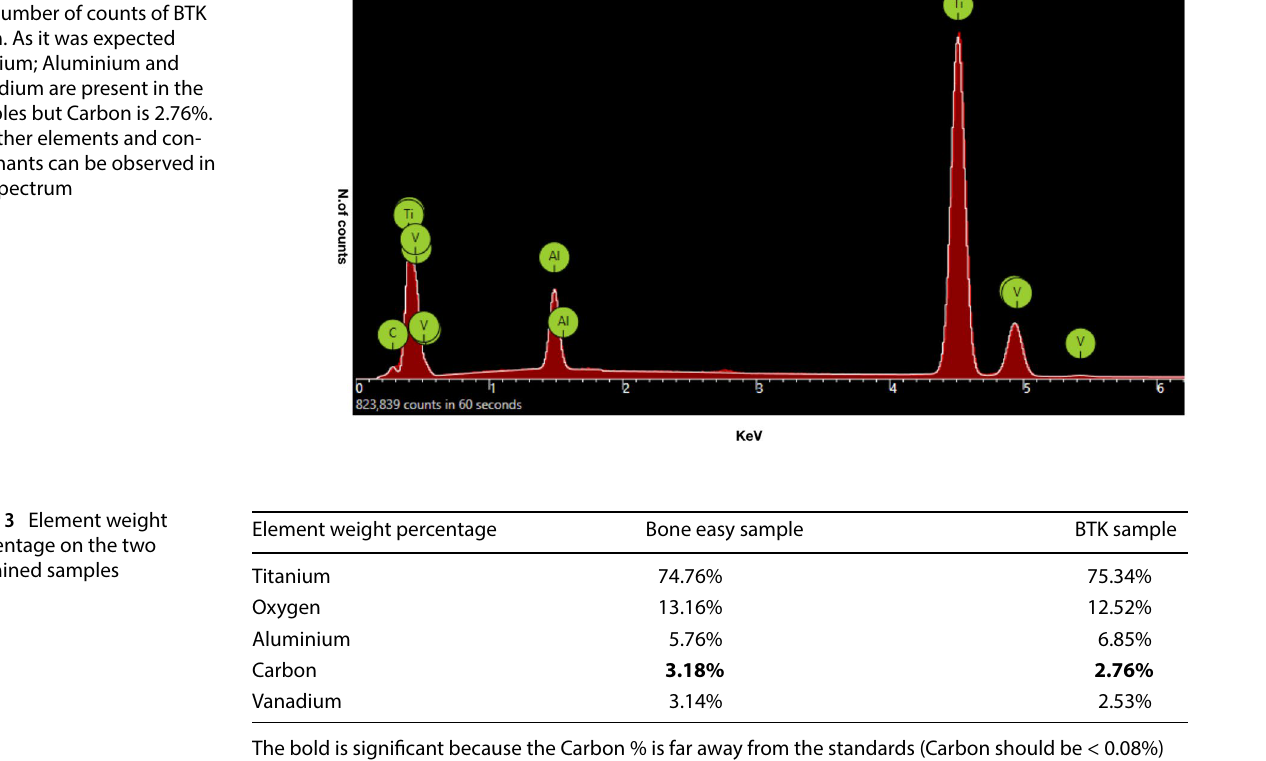
Fig. 4 Chemical composition per number of counts of BTK mesh. As it was expected Titanium; Aluminium and Vanadium are present in the samples but Carbon is 2.76%.